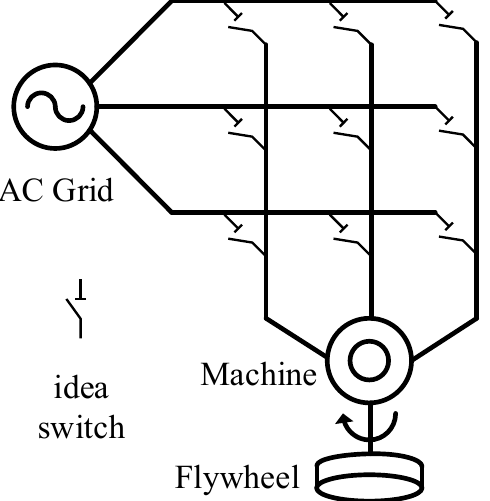
Figure 27. Topology of matrix converter with flywheel.